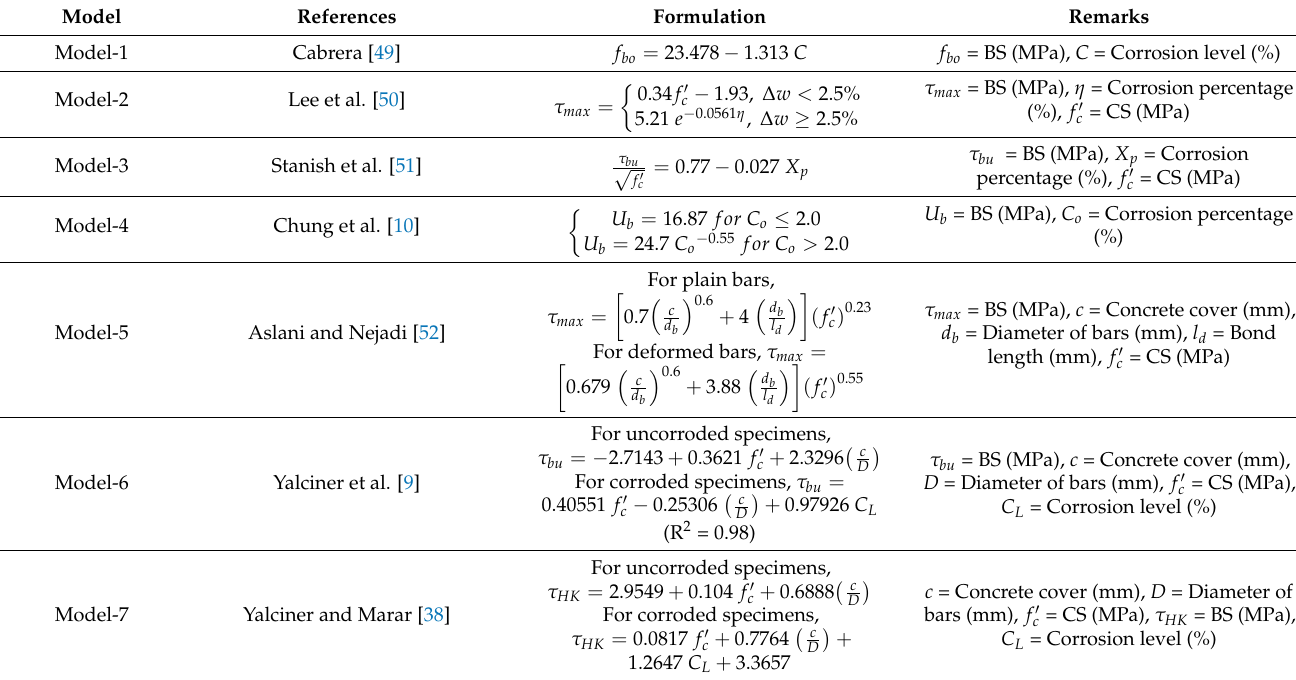
Table 4. Details of analytical